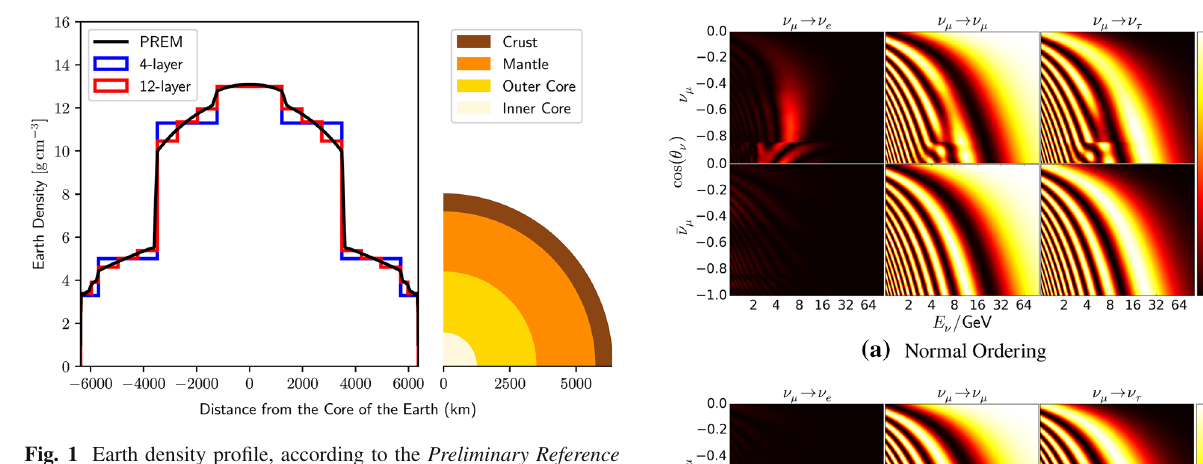
experiments, recent global fits prefer Normal over